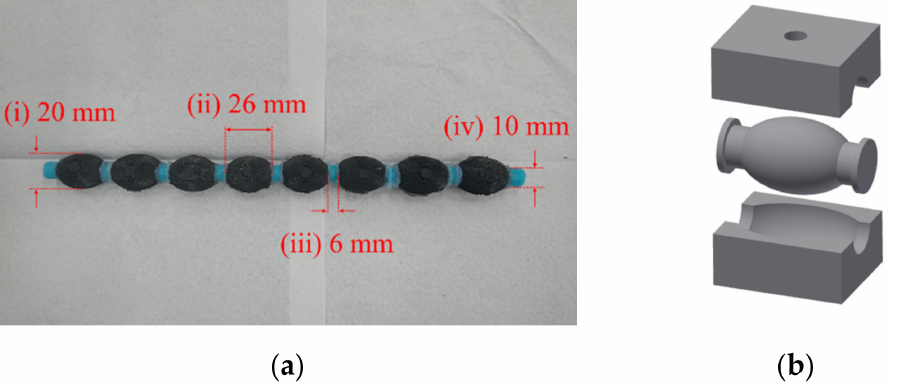
Figure 1. ( a ) MAE crawler. ( i ) Short semi-axis, s 1 /s 2 = 10 mm (rotationally symmetric about long centre axis of the crawler); ( ii ) Long semi-axis, s 3 = 15.3 mm. Ends of the ellipsoid were trimmed so that the real length was 26 mm rather than 30.6 mm; ( iii ) Connector diameter; ( iv ) Connector length. ( b ) Exploded view of 3-part mold used to cast a single ellipsoidal MAE unit. The slurry is injected through the hole at the